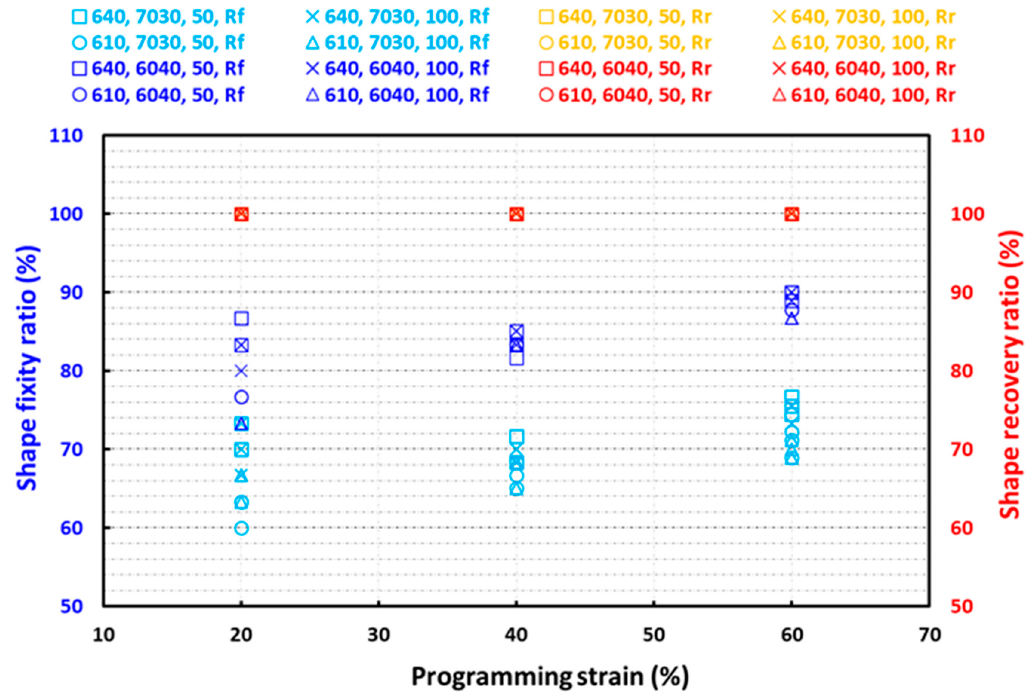
Figure 15. Shape fixity and shape recovery ratios of all samples.